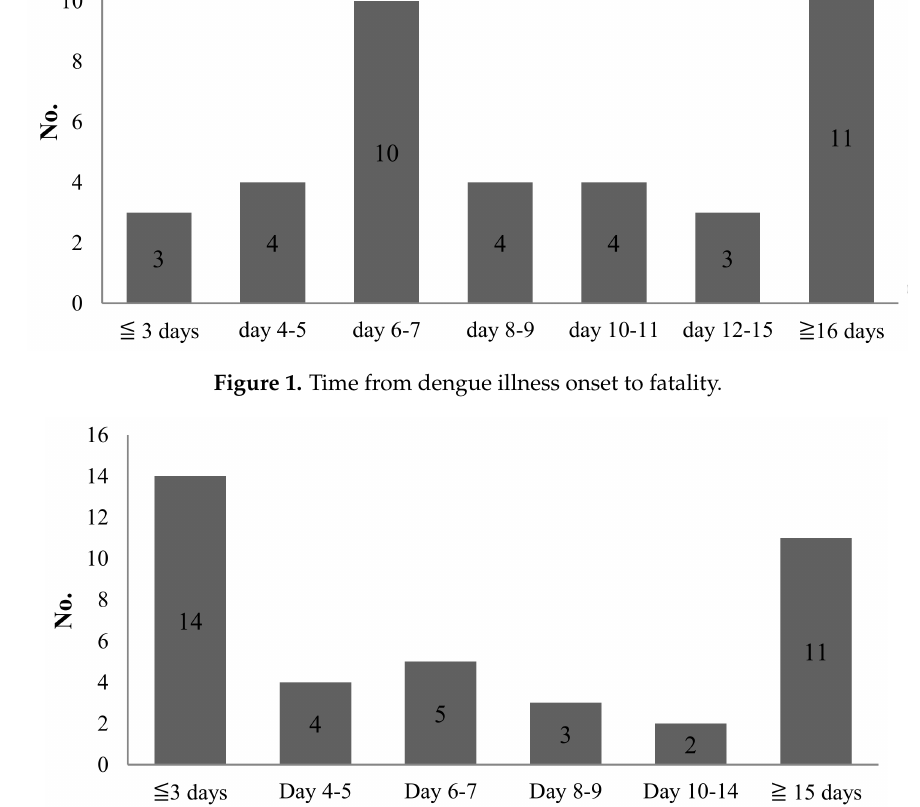
Figure 2. Time from hospital presentation to